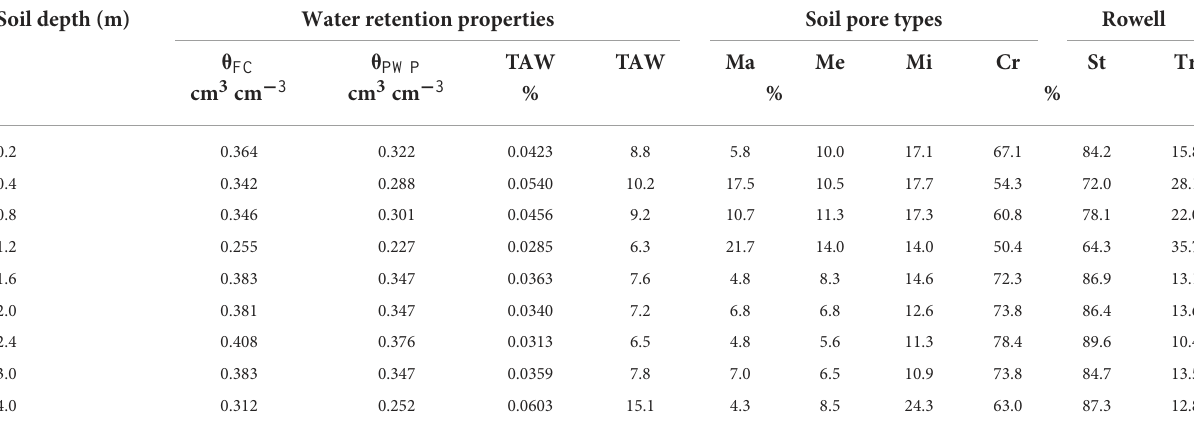
TABLE 2 Soil properties, expressed in terms of water retention properties and soil porosity for the upper 4 m of the soil profile. Soil depth (m)